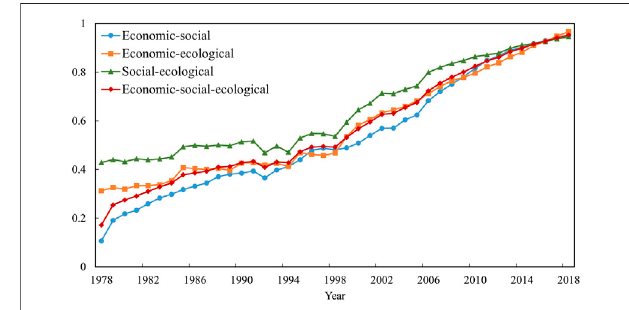
FIGURE 4 | Changing curves for the values of NRUBs. FIGURE 5 | Evolution curves of coupling coordination degrees of